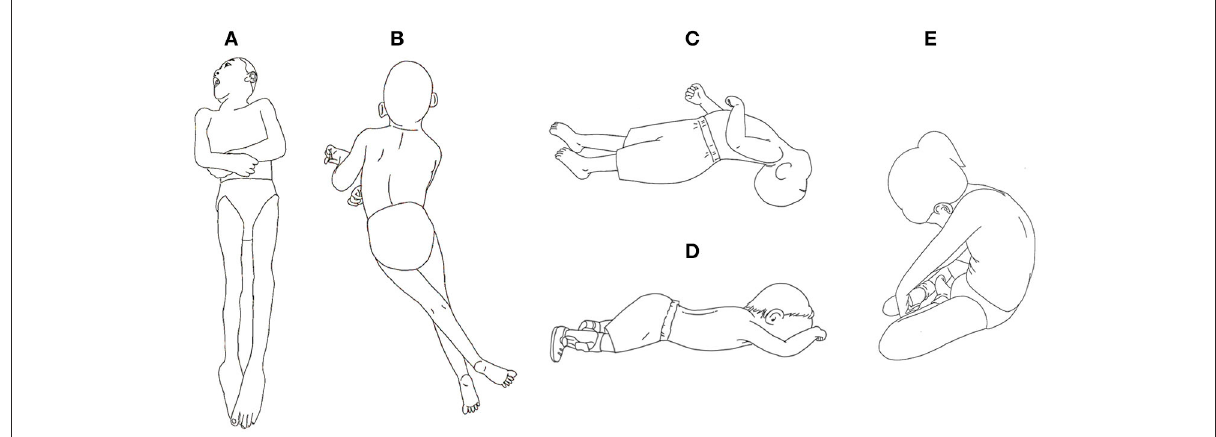
FIGURE1 Typical posture of a child with spastic quadriplegic CP: (A) supine; (B) prone; (C) lateral view of supine; (D) lateral view of prone; (E)